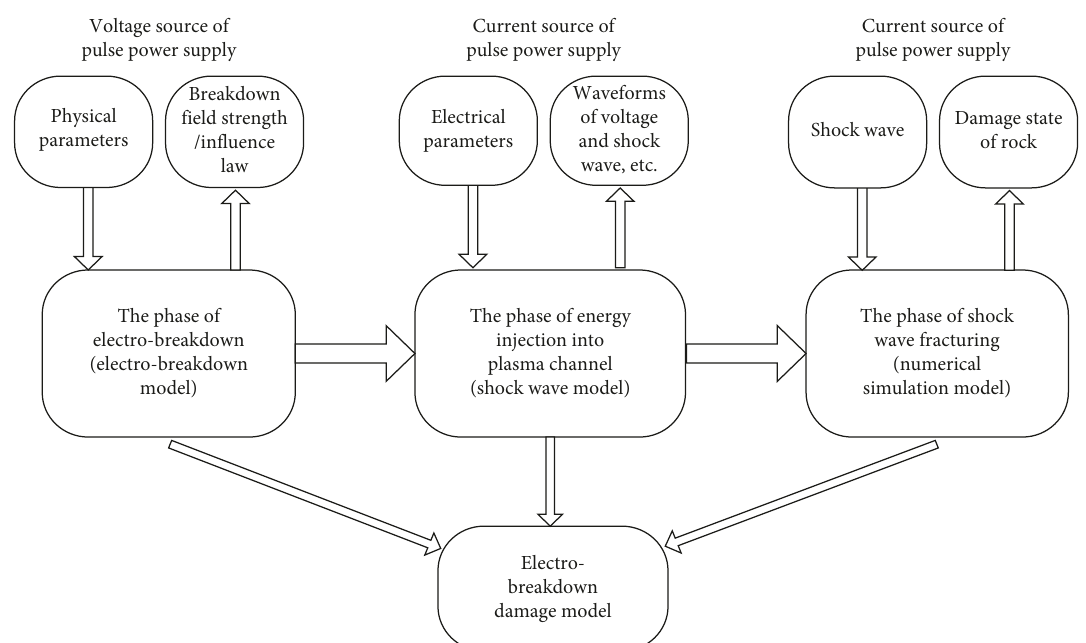
Figure 3: Structural composition and information flow diagram of the electro-breakdown damage model.